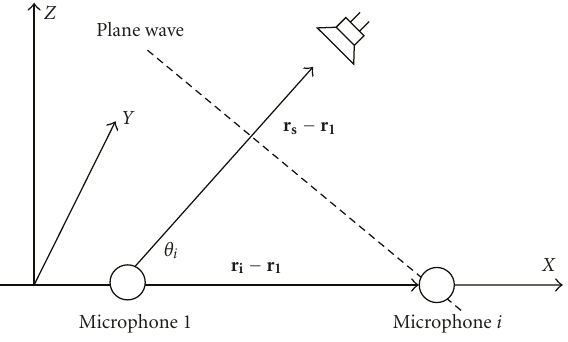
Figure 1: Geometry model of plane wave and two